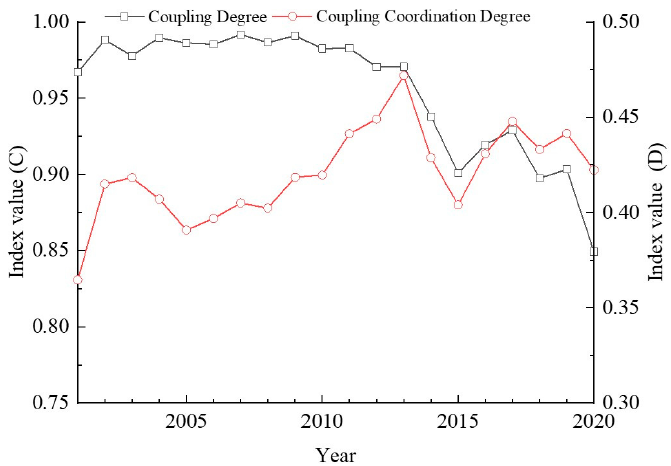
Figure 5. Interannual change trends in the water–ecology–economy coupling degree and coupling coordination degree in the Wuding River watershed from 2001 to 2020 .